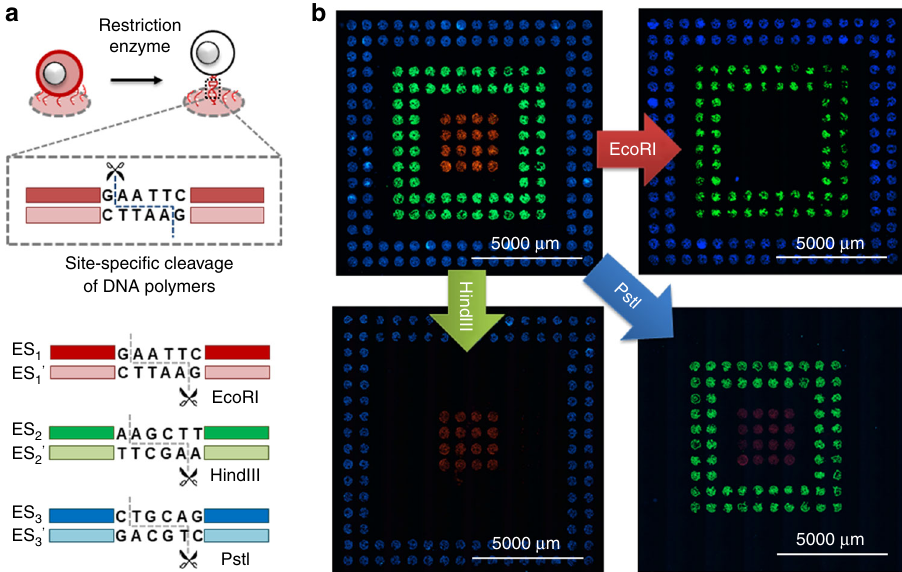
Fig. 7 Postediting of the DNA polymer cocoons for precise handling of cells. a Schematic illustration showing the site-speci fi c cleavage of the DNA polymers by the restriction endonucleases, EcoRI-HF, HindIII-HF, and PstI-HF. b Typical fl uorescent scanning images showing the cells on the glass slide surfaces before and after the site-speci fi c release of cells: the captured cells on the DNA sequence-patterned surface before the treatment, and remained cells on the slides after the treatments with the restriction endonucleases, EcoRI-HF, HindIII-HF, and PstI-HF respectively. Individual slides are separately used for release experiments and scanned on a cell imaging multimode reader. Cells are released from the speci fi c capture zones as a result of the site- speci fi c cleavage of the target DNA polymers. Scale bars, 5000 μ